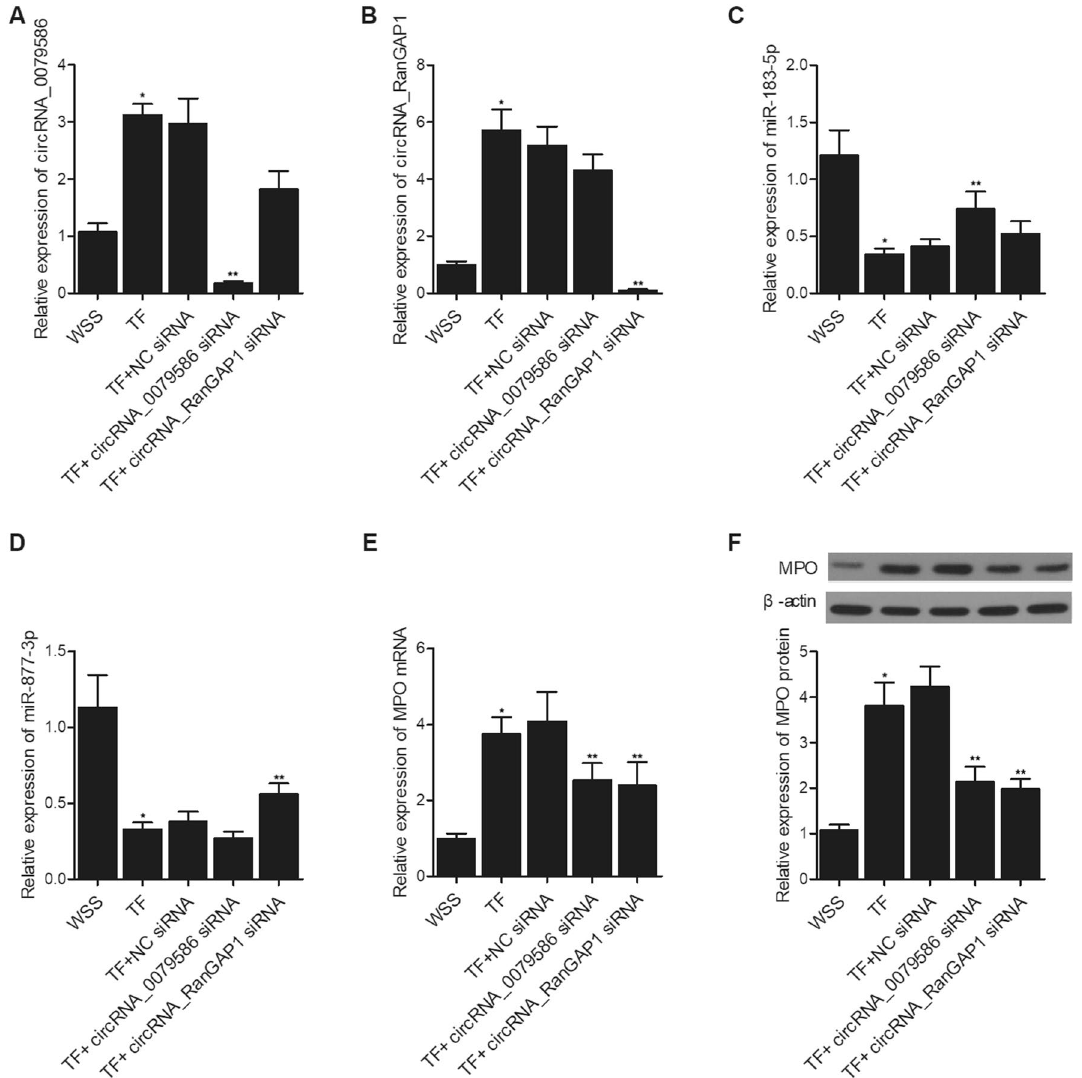
Figure 4. Down-regulation of circRNA_0079586 and circRNA-RanGAP1 with siRNA altered the expression of circRNA-0079586, circRNA-RanGAP1, miR-183-5p, miR-877-3p and MPO in WSS- and TF-treated HUVECs. ( A ) CircRNA-0079586 siRNA dramatically suppressed the expression of circRNA-0079586 in TF-treated HUVECs (* P < 0.05 vs. WSS; ** P < 0.05 vs. TF + NC siRNA). ( B ) CircRNA-RanGAP1 siRNA dramatically suppressed the expression of circRNA-RanGAP1 in TF-treated HUVECs (* P < 0.05 vs. WSS; ** P < 0.05 vs. TF + NC siRNA). ( C ) CircRNA-0079586 siRNA significantly enhanced the expression of miR-183-5p in TF-treated HUVECs (* P < 0.05 vs. WSS; ** P < 0.05 vs. TF + NC siRNA). ( D ) CircRNA-RanGAP1 siRNA significantly enhanced the expression of miR-877-3p in TF-treated HUVECs (* P < 0.05 vs. WSS; ** P < 0.05 vs. TF + NC siRNA). ( E ) CircRNA-0079586 siRNA and circRNA-RanGAP1 siRNA decreased the expression of MPO mRNA in TF-treated HUVECs (* P < 0.05 vs. WSS; ** P < 0.05 vs. TF + NC siRNA). ( F ) CircRNA-0079586 siRNA and circRNA-RanGAP1 siRNA decreased the expression of MPO protein in TF-treated HUVECs (* P < 0.05 vs. WSS; ** P < 0.05 vs. TF + NC fragility as well as reduced resistibility of the aneurysmal wall 38 . A reduced magnitude of WSS can also enhance chronic inflammation as well as atherosclerotic changes induced by macrophages, which in turn cause the thin- ning of the aneurysmal wall to cause further rupture 39 . In this study, we performed qPCR to compare the differ- ent expression of circRNA-0079586, circRNA-RanGAP1, miR-183-5p, miR-877-3p and MPO in the endothelial cells collected from UIAs and RIAs patients. The expression of circRNA-0079586 and circRNA-RanGAP1 was significantly enhanced in RIAs patients when compared with UIAs patients. The expression of miR-183-5p and miR-877-3p was remarkably repressed in RIAs patients when compared with UIAs patients. The expression of MPO was significantly activated in RIAs patients when compared with UIAs patients. Wang et al. used high throughput sequencing to screen the effects of circRNAs on GM and paired non- cancer tissues. They found that circ_0079586 was up-regulated in GM specimens 40 . Located at chr7: 23353140— 23383472 and containing 586 base pairs, circ_0079586 is generated by the splicing of IGF2BP3. In this study,